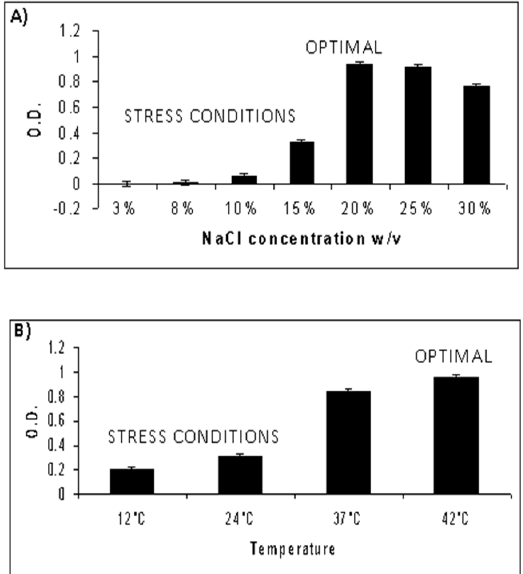
Figure 1. ( A ) Growth of the isolate NA6-27 in different salt concentrations at 37 °C after three weeks incubation in standard haloarchaeal medium. Error bars shows ± standard error. Stress conditions are indicated as is the optimal salinity; ( B ) Growth of isolate NA6-27 at different temperatures in 25% (w/v) salt after three weeks period. All cultures were grown in haloarchaeal standard medium. Error bars shows ± standard error. Stress conditions are indicated as is the optimal growth temperature.